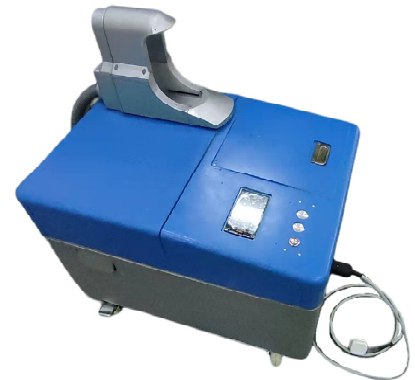
Figure 6. Prototype of excretion nursing equipment.